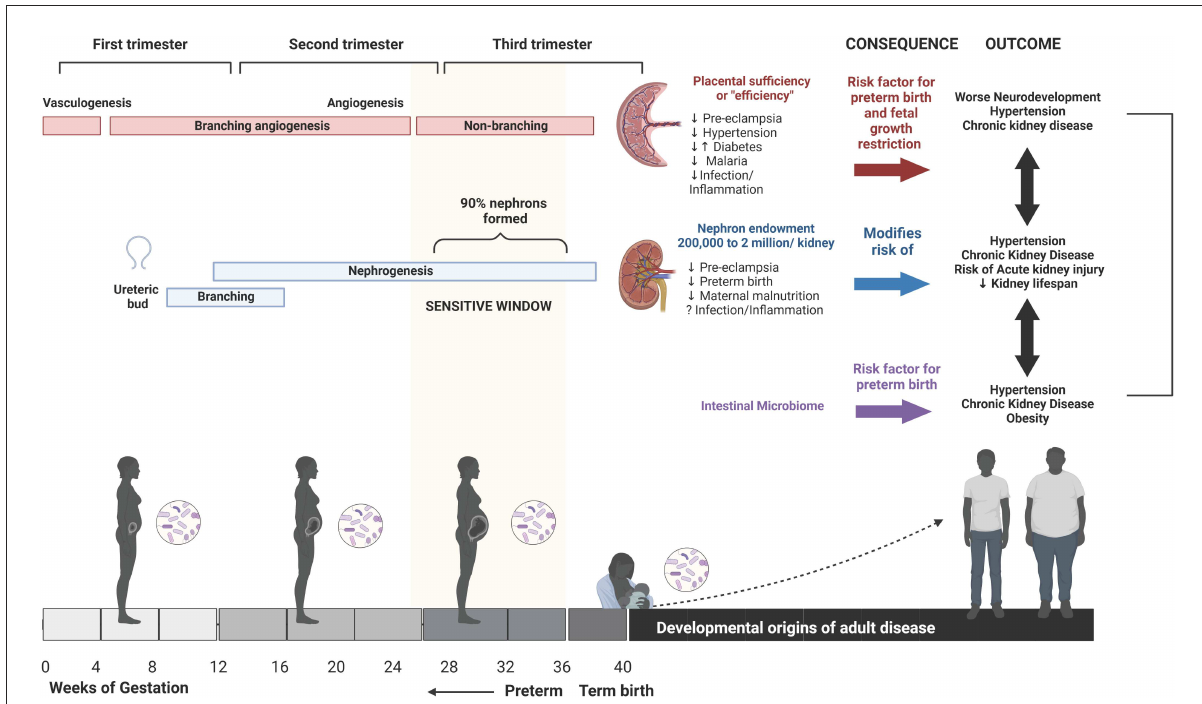
FIGURE1 Developmental origins of health and disease. From the time of conception, and throughout gestation, the health of the mother and resulting changes in the in utero environment can impact the health and development of the child and last well into adulthood. Maternal health, including stress, nutritional status, metabolic disorders, infection, and inflammation during pregnancy, can impact in utero development via multiple pathways including altered placental vascular development, nephrogenesis, and microbiome. This can result in an increased risk of poor health outcomes in the child, including a potential impact on neurodevelopmental processes, or may manifest in adulthood as an increased risk of metabolic disorders, cardiovascular disorders, or acute kidney injury. Created using